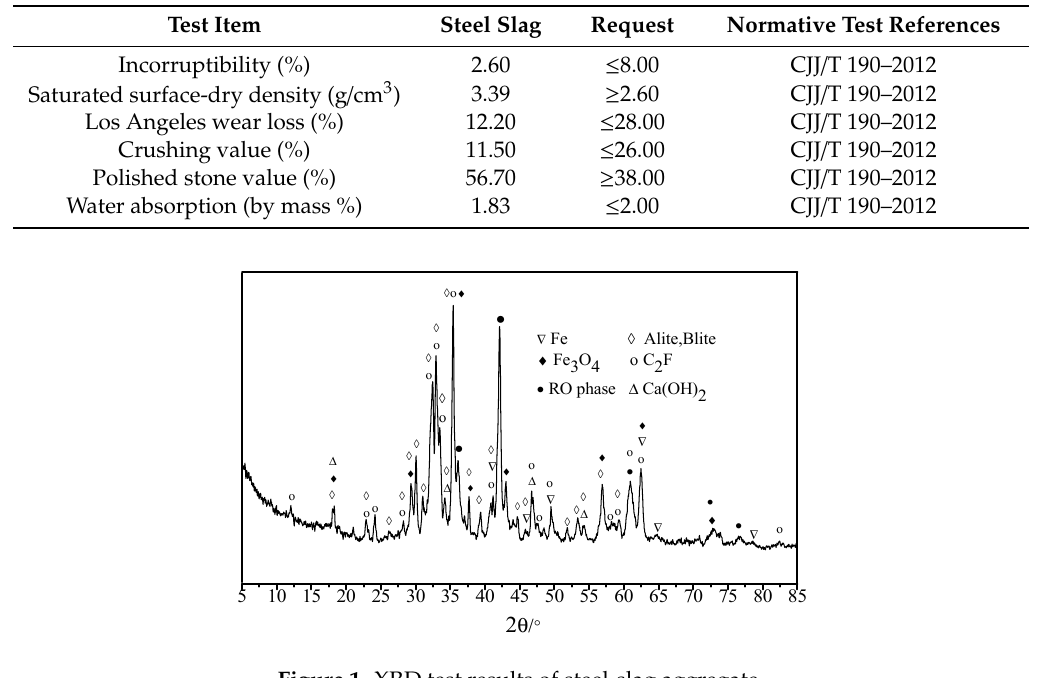
Figure 1. XRD test results of steel-slag aggregate. Table 2. Technical indices of coarse aggregates.